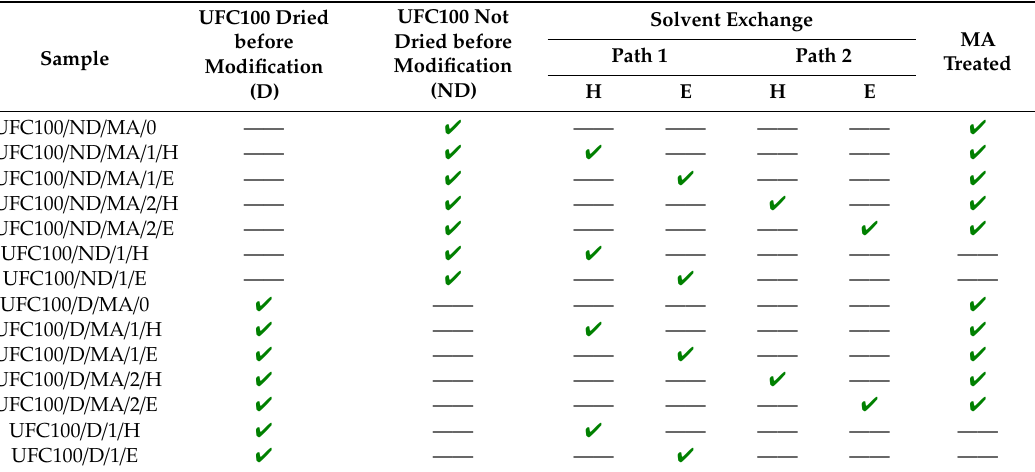
Figure 1. Hybrid chemical modification of cellulose fibers: Path 0—regular surface modification with maleic anhydride (MA); Path 1—solvent exchange before the surface modification with MA; Path 2—solvent exchange after the surface modification with MA. Table 2. Summary of all performed cellulose fiber